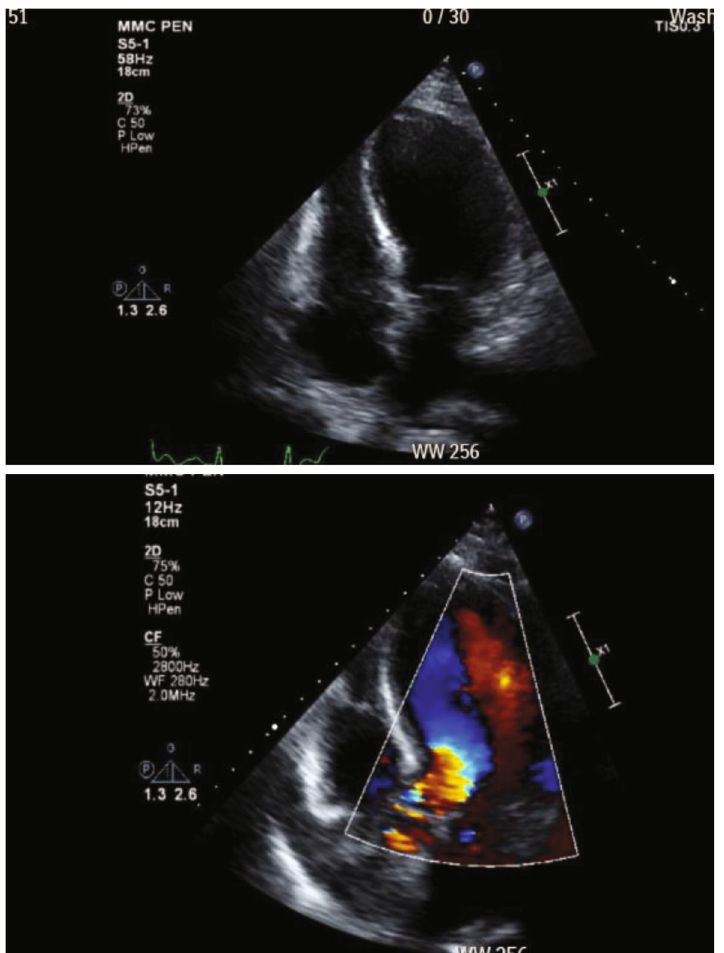
Figure 2: Echocardiography showing left ventricular